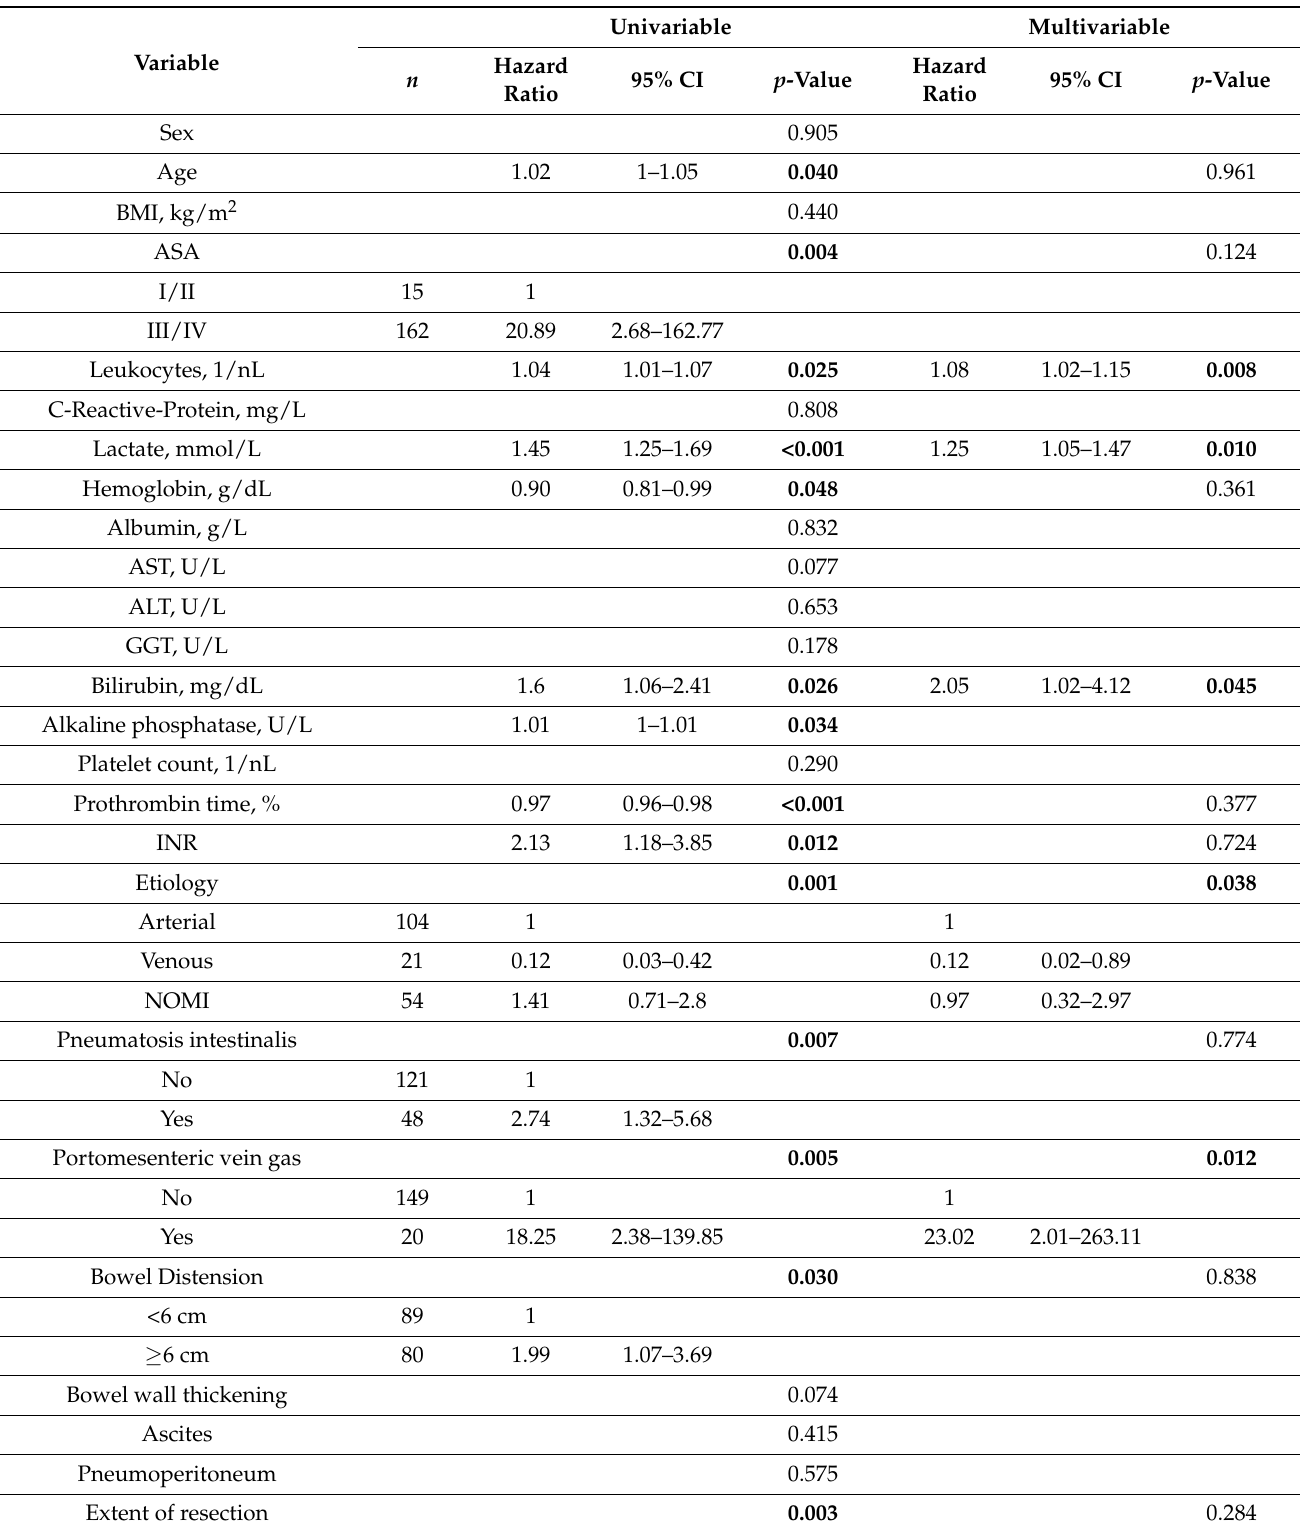
Table 2. Univariable and multivariable analysis of in-hospital mortality (overall